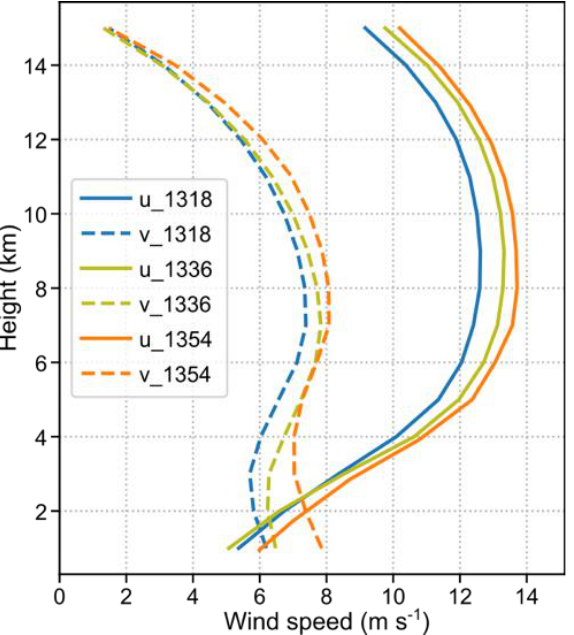
Figure 10. The VWPs of the retrieved three-dimensional winds averaged over a region of 40 × 40 km centered at the supercell at 1318 LTC (blue), 1336 LTC (green), and 1354 (orange) LTC.